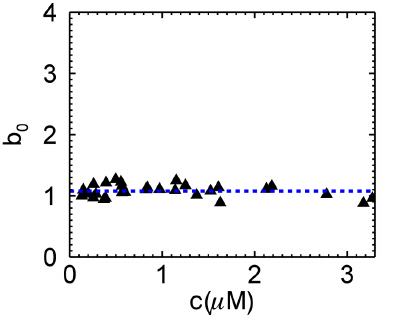
Figure 5. Normalized brightness of EGFP versus concentration in yeast cells. The same data shown in Figure 1A are reanalyzed with segmented brightness analysis, which removes the bias (mean and SD of brightness data: .1.08 6